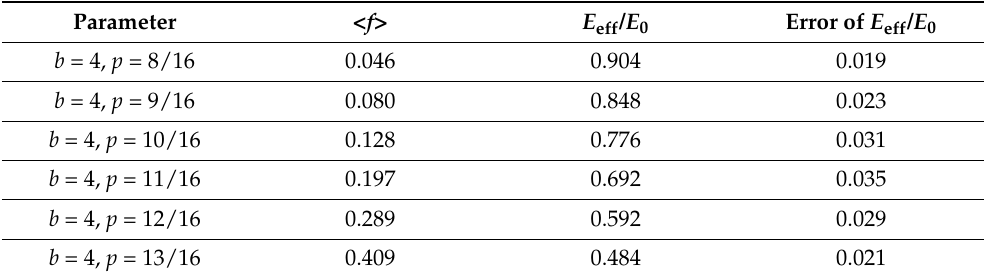
Table 2. Macroscopic porosity <f> and effective elastic modulus E eff / E 0 of multifractal porous materials synthesized by the two-parameter binomial multiplicative cascades.